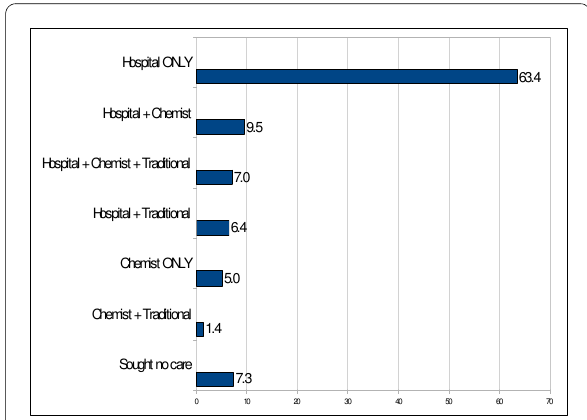
Figure 1 Care-seeking behaviour for hypertension treatment .